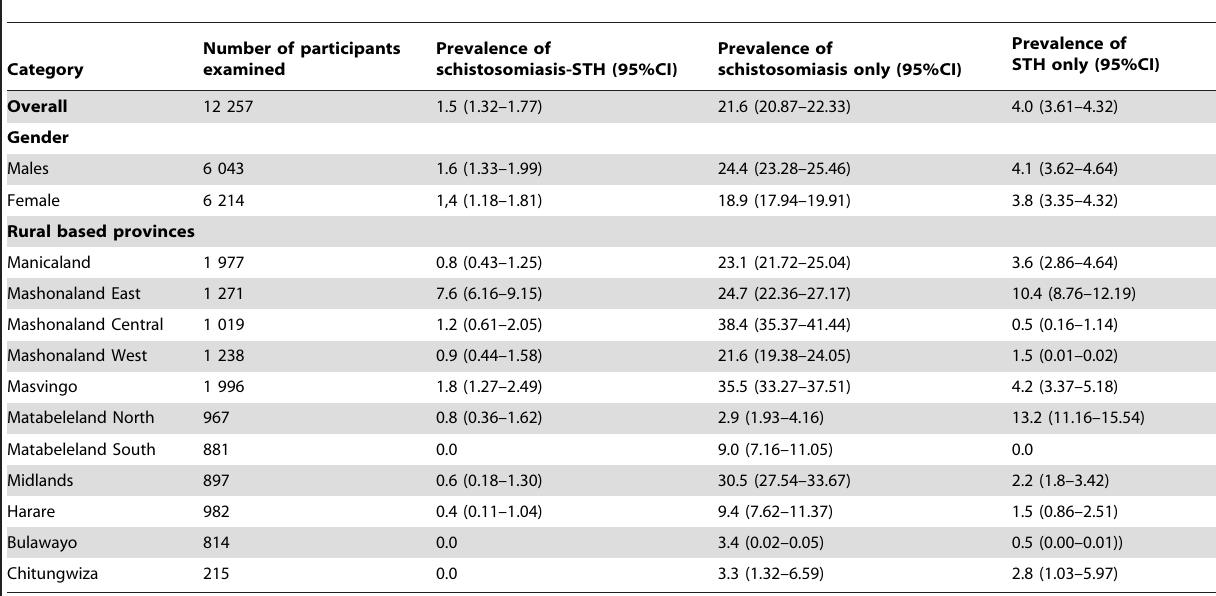
Table 5. Prevalence of schistosomiasis and soil transmitted helminthiasis co-infection combinationsby province in Zimbabwe in 2011.